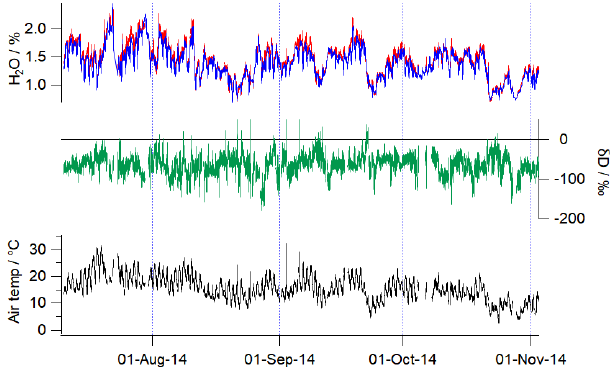
Figure 7. Measured O 2 mole fractions for the measurement pe- riod. The narrow spikes are artefacts due to stray solar radiation near 18:00 on sunny days, as discussed in the text. The insert shows details of the spike on 2 September 2014.